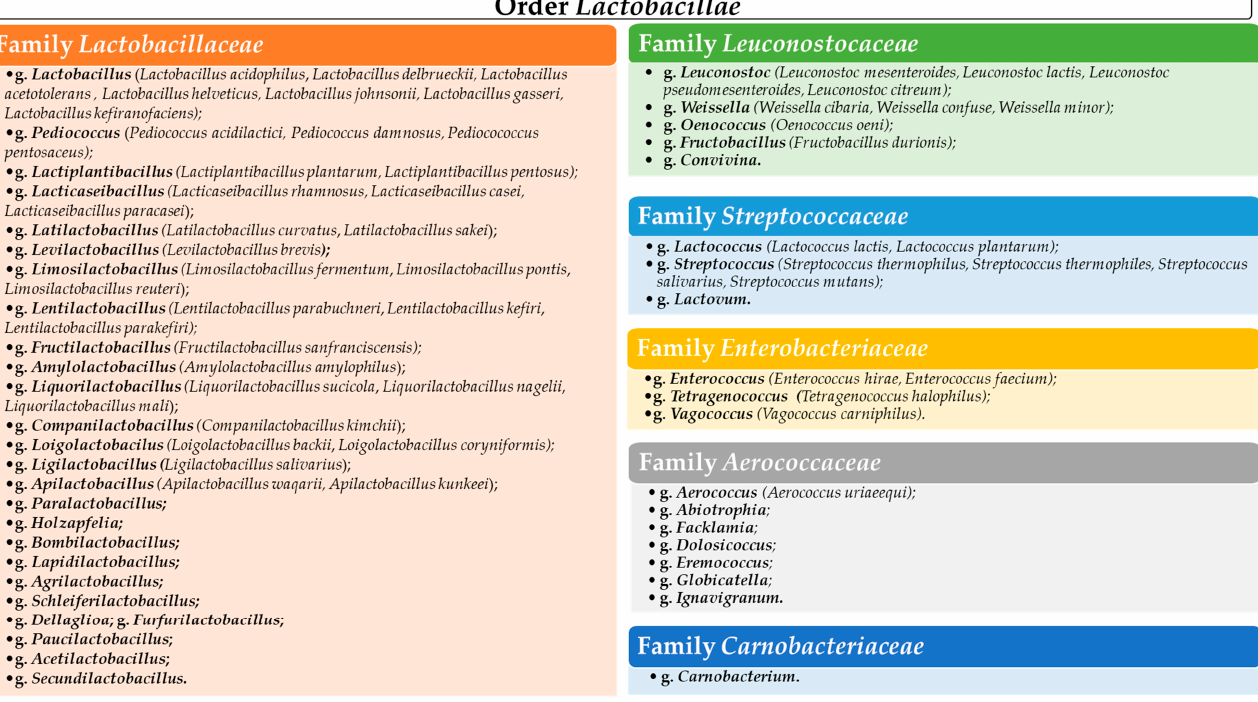
Figure 2. Lactic acid bacteria taxonomy.